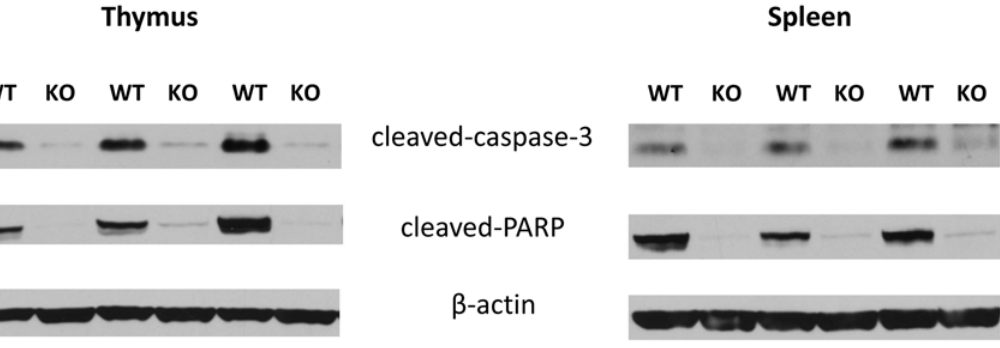
Figure 5. CB 2 receptor deficiency decreases apoptosis in septic thymus and spleen. Proteolytic cleavage of caspase-3 and PARP in thymus and spleen protein extracts from CB 2 WT and KO mice was examined using Western blotting. Bands were detected by enchanced chemiluminescence (ECL). Results shown are representative of 3 experiments.